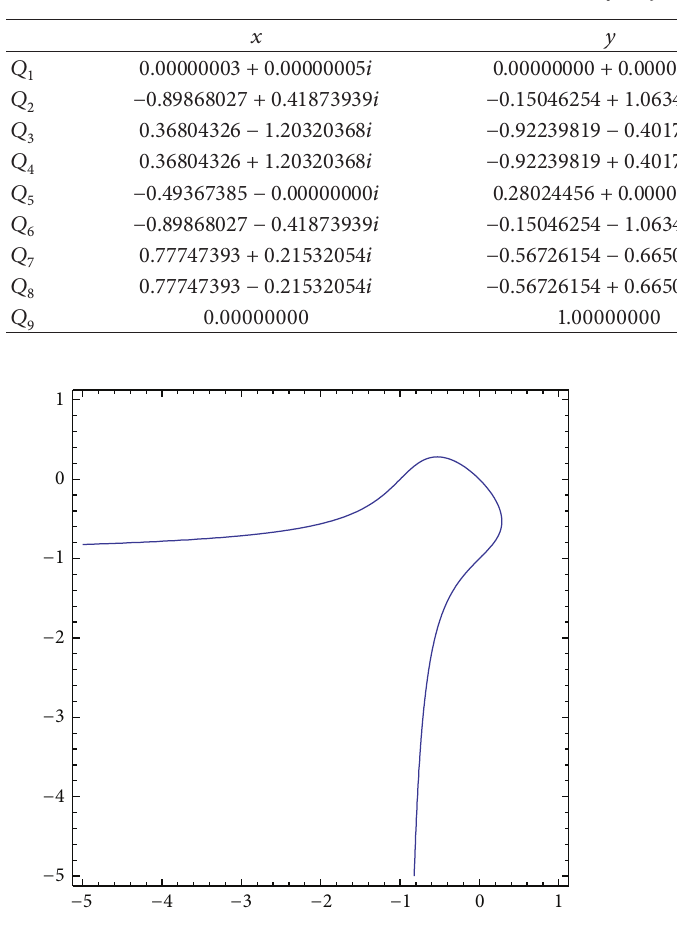
Table 1: Results for 𝑓(𝑥,𝑦) = 0 in Example 1.